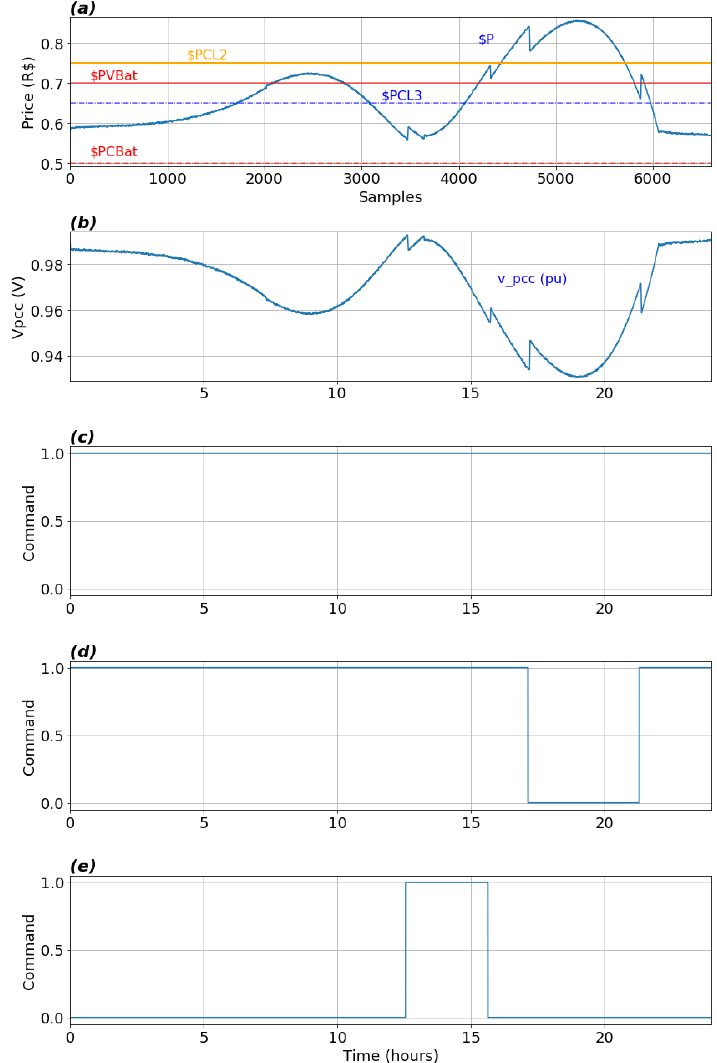
Figure 28. MG operating in islanded mode with active power consumption. Commands: ( a ) Active energy price; ( b ) Bus voltage; ( c ) Battery bank command; ( d ) Load 2 command; ( e ) Load 3